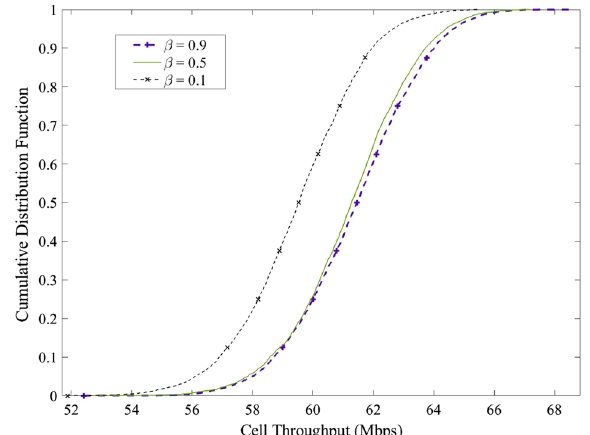
Fig. 10 Impact of beta value on cell throughput for the OSGRR. The highest cell throughput is achieved at a value of β